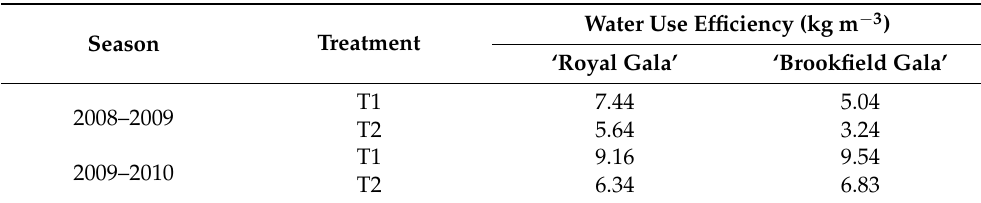
Table 5. Water productivity in ‘Brookfield Gala’ and ‘Royal Gala’ apple trees in two seasons and two irrigation management